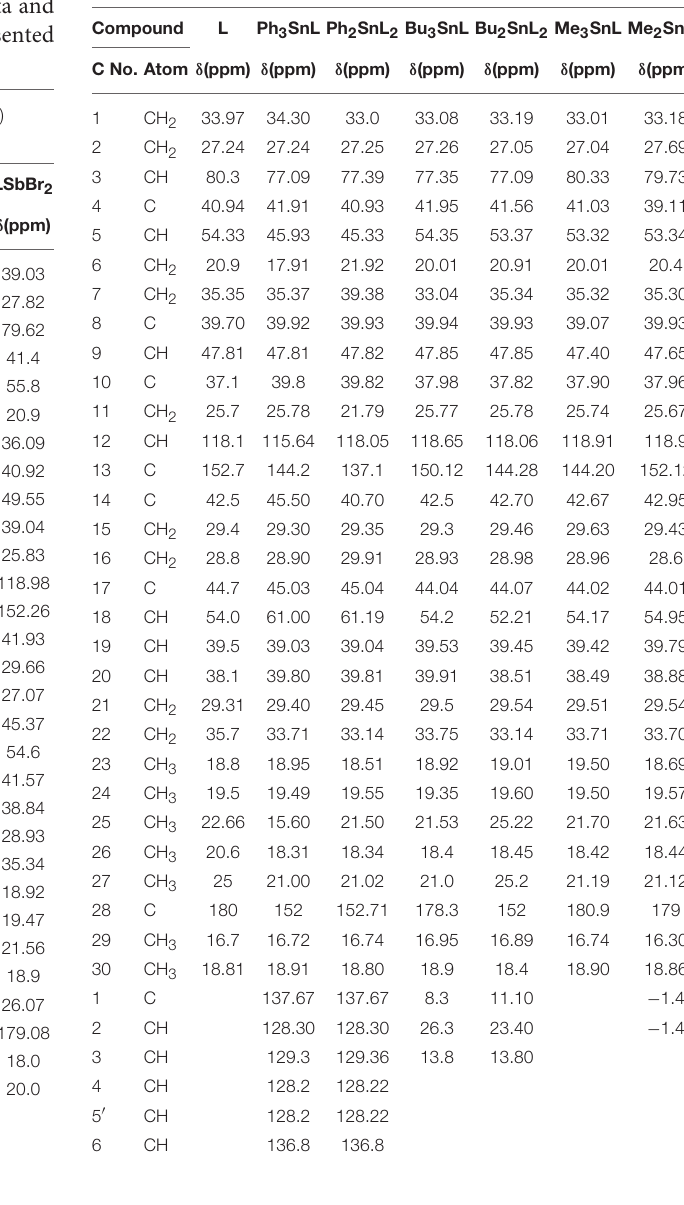
TABLE 5B | 13 CNMR spectral data of ligand and their metal (Tin) complexes.